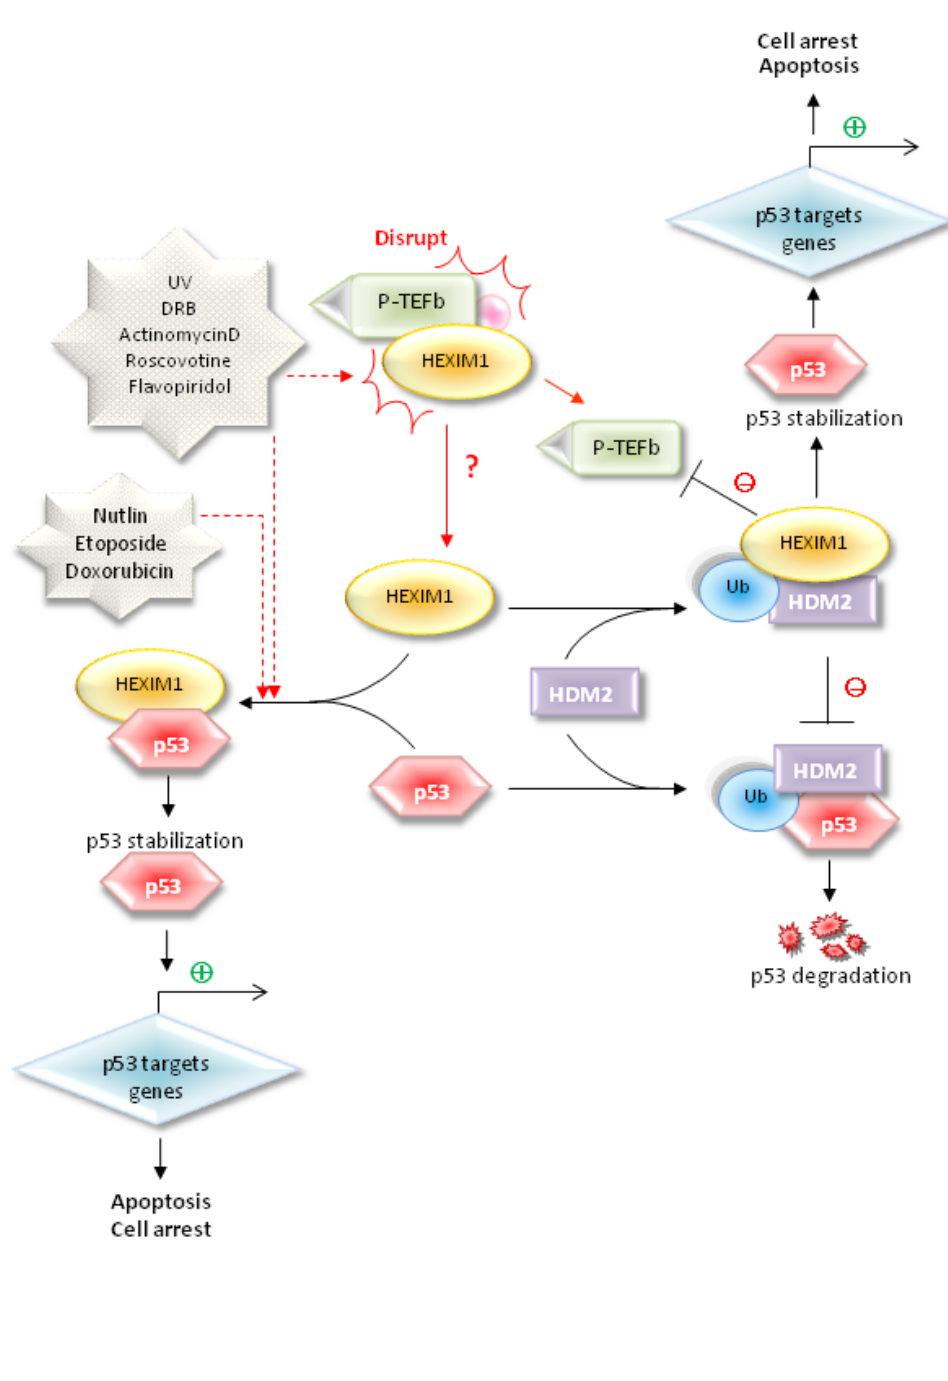
Figure 3. Treatments with UV radiation, flavopiridol, DRB, roscovitine, actinomycin D, and doxorubicin, etoposide, and nutlin-3 increase the HEXIM1-p53 interaction and lead to induction of p53. UV, flavopiridol, DRB, roscovitine, and actinomycin D treatments can release more “free” HEXIM1 from the large P-TEFb complexes and may further enhance the association between p53 and HEXIM1. HEXIM1 not only competes with HDM2 in binding to p53, but also interacts with HDM2, resulting in activation of p53. The HDM2-ubiquitinated HEXIM1, which is not degraded through the proteasome-mediated pathway, exerts stronger inhibition on P-TEFb